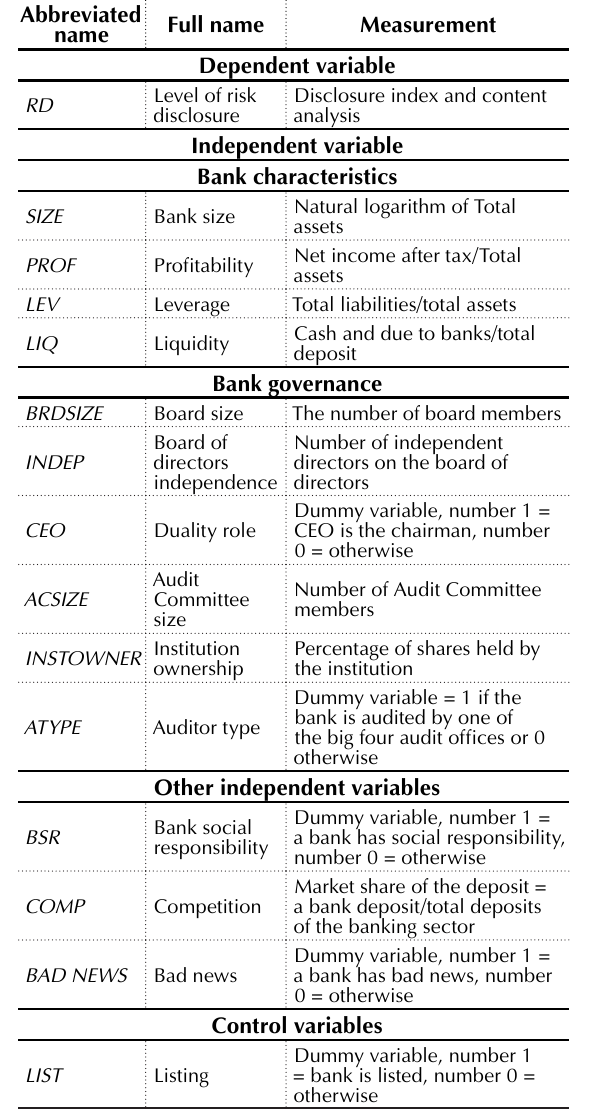
Table 2. Measurement of